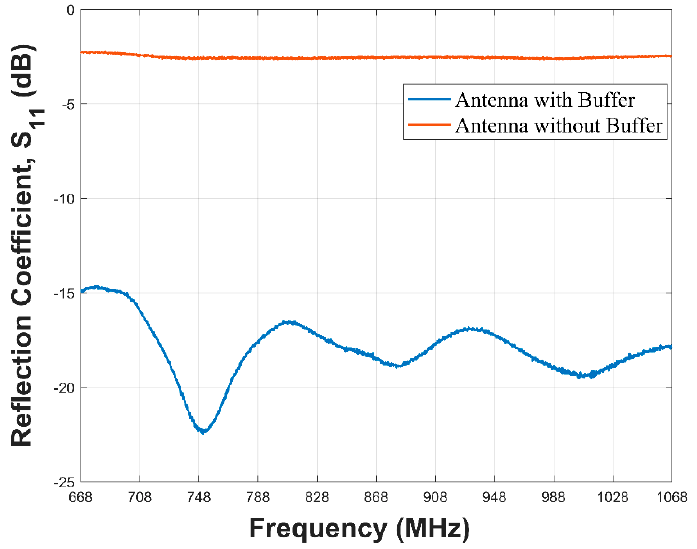
Figure 17. Measured results of buffered and barrierless antennas.